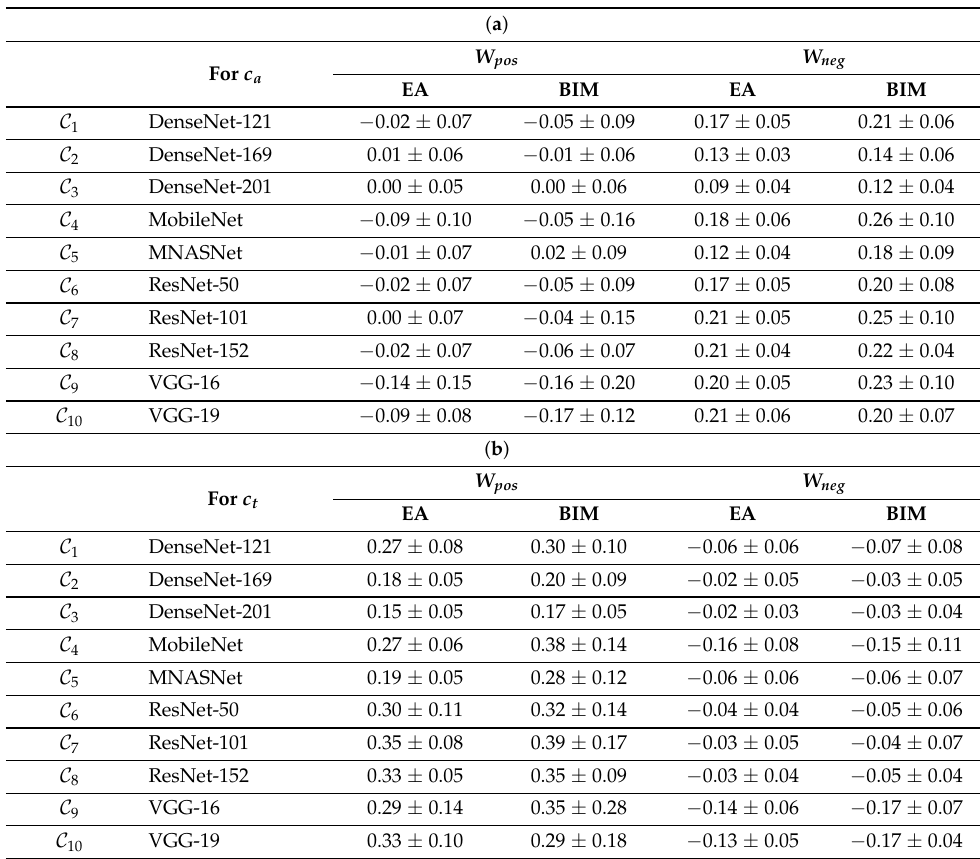
Table 7. For c a (a) and c t (b), average and standard deviation of the activation change in the positively related ( W pos , column 2) and negatively related ( W neg , column 3)